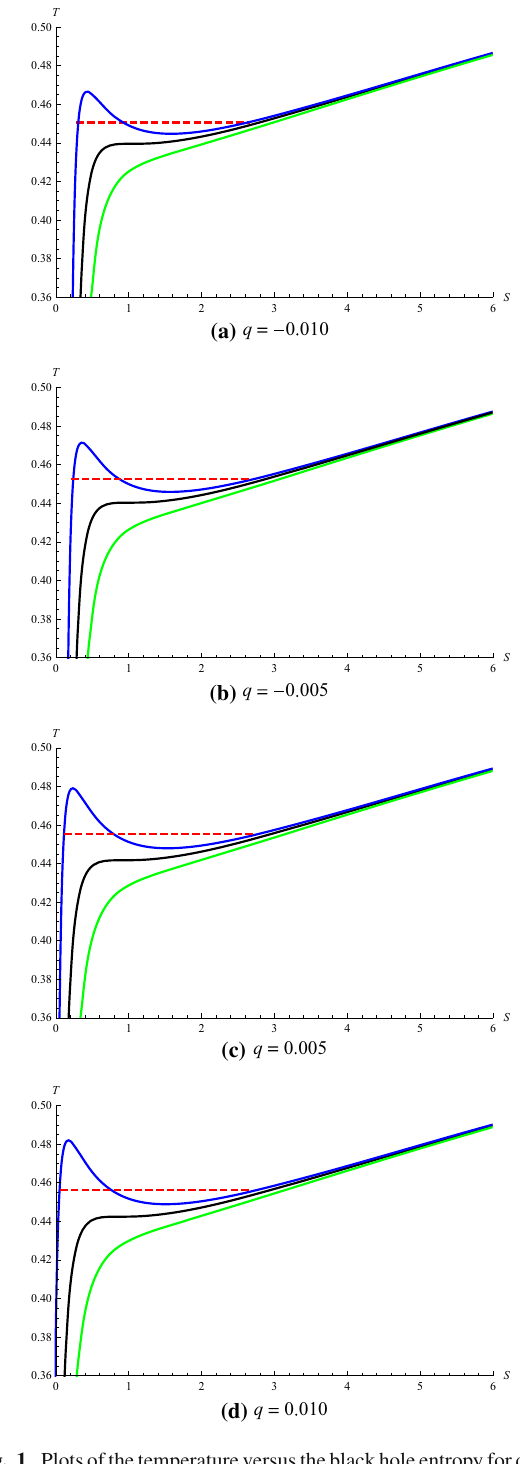
Fig. 1 Plotsofthetemperatureversustheblackholeentropyfordiffer- ent q. The red dash line corresponds to the temperature of the first order phase transition. The values of the electric charge chosen (from top to bottom) are as follows. a Q = 0 . 0286384 < Q C , Q = 0 . 0486384